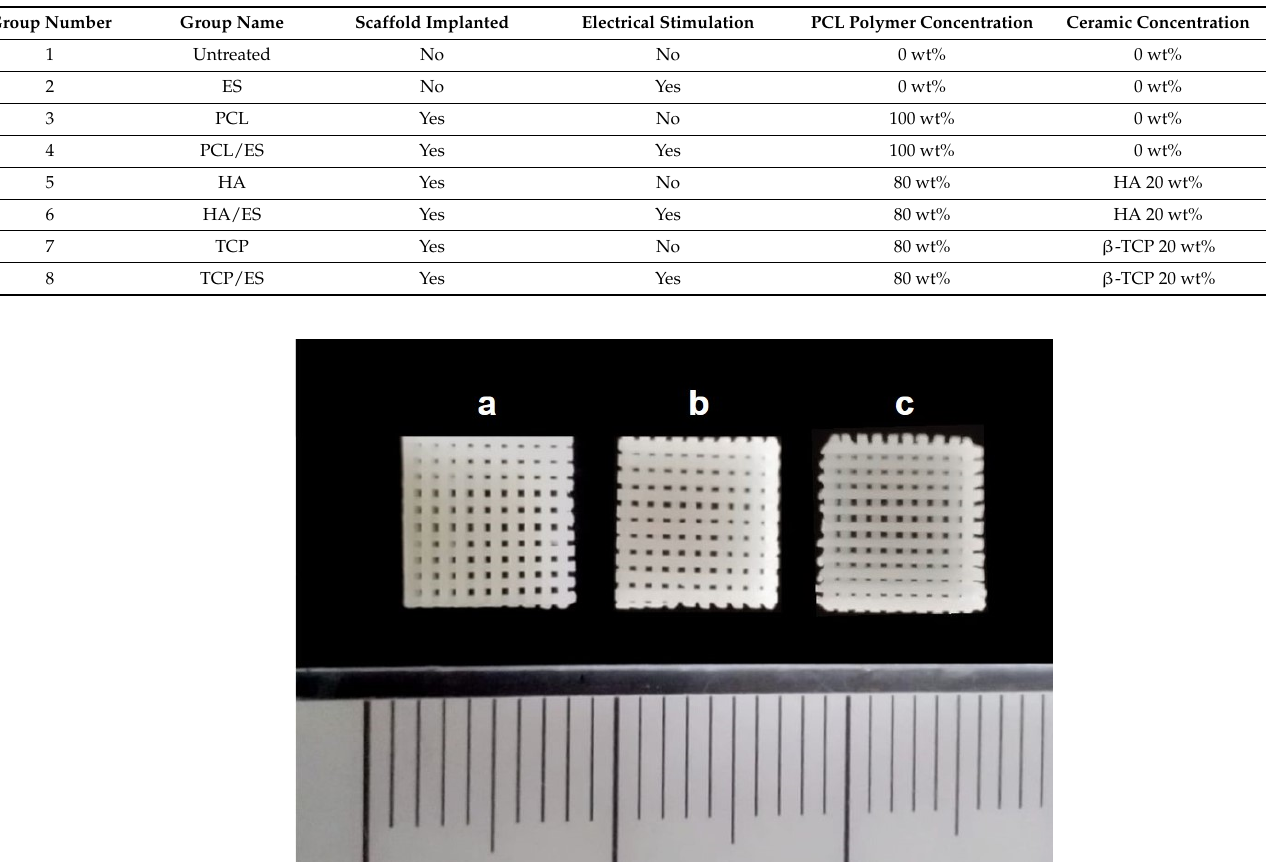
Table 1. Experimental groups for in vivo study.